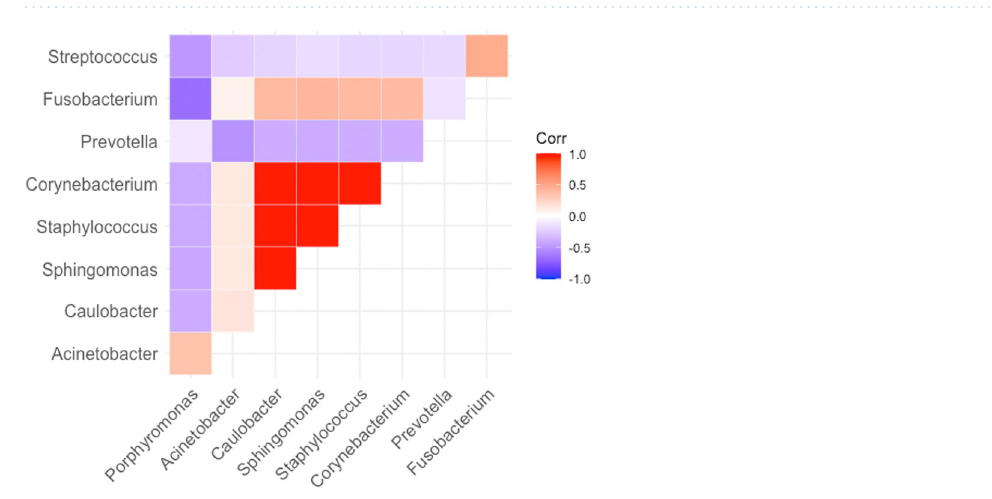
Figure 7. Correlation between different bacteria genera from odontogenic rhinosinusitis samples. Red and blue indicate positive and negative correlations from 16S data,